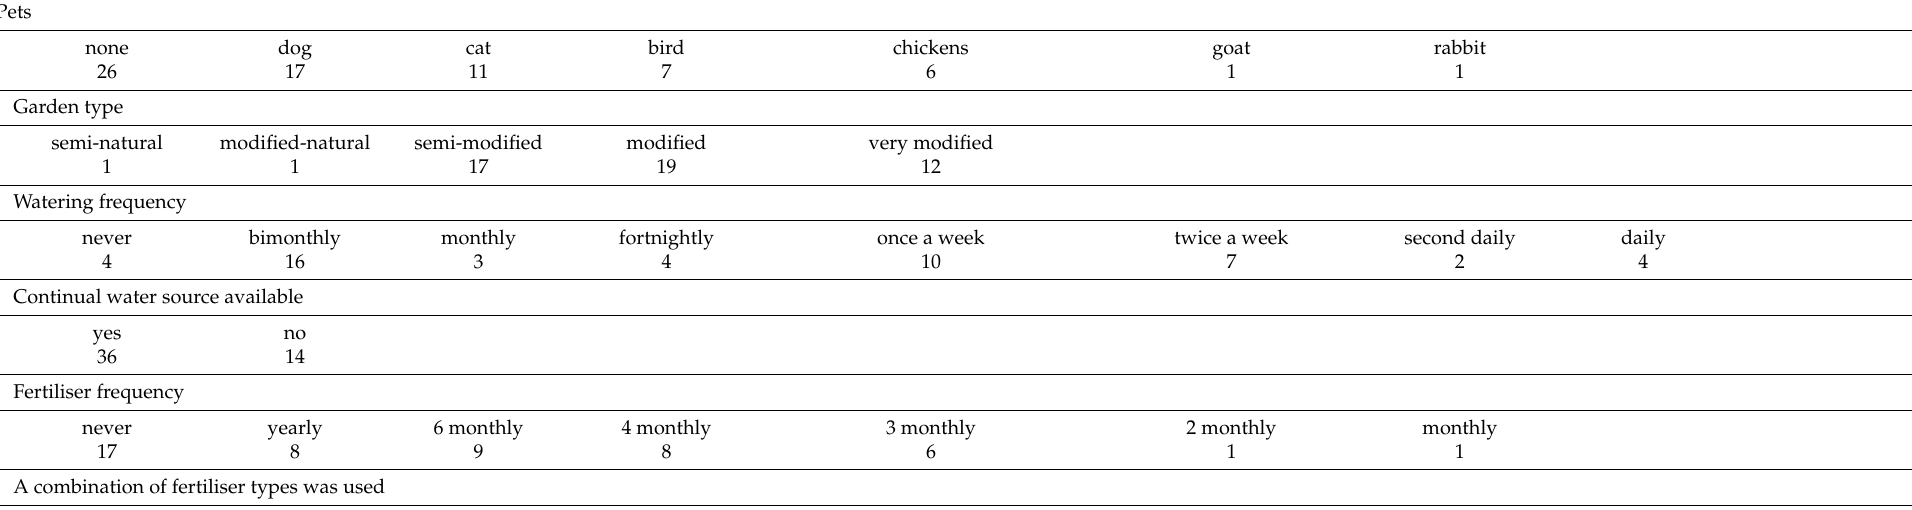
Table 1. A summary of responses by householders to questions pertaining to wildlife in their yards and yard management activities. A total of 50 households responded to all questions in the written survey. Categorisations are based on information received from